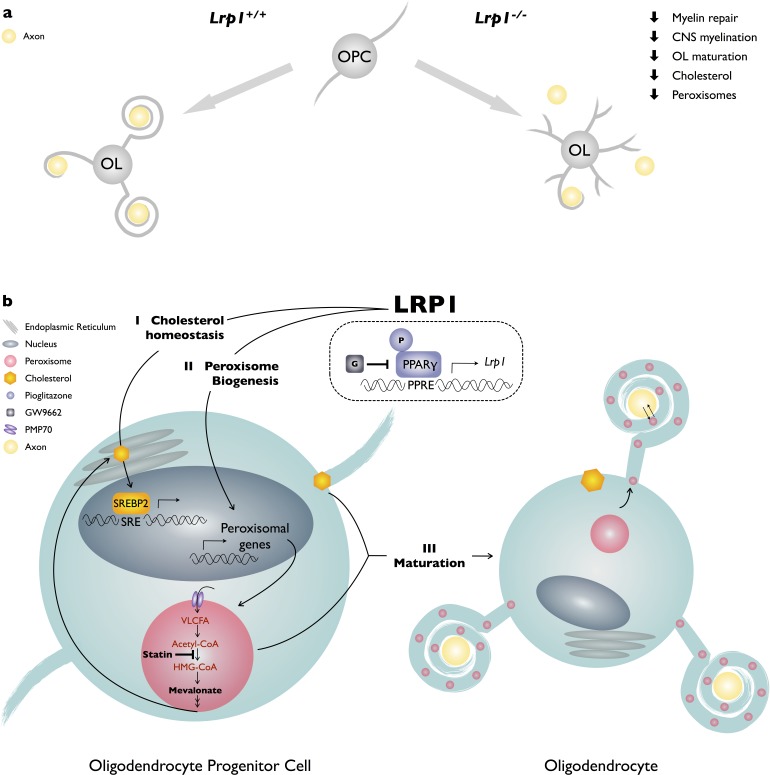
Working model of LRP1 regulated pathways in developing OLs.(a) LRP1 in the OL-lineage is necessary for proper CNS myelin development and the timely repair of a chemically induced focal white matter lesion. In OPCs, Lrp1 deficiency leads to dysregulation of cholesterol homeostasis and impaired peroxisome biogenesis. (b) LRP1 is a key regulator of multiple pathways important for OPC differentiation into mature myelin producing OLs: (I) LRP1 regulates cholesterol homeostatsis; (II) LRP1 regulates peroxisome biogenesis; and (III) the combined treatment of Lrp1 deficient primary OPCs with cholesterol and pioglitazone is sufficient to drive maturation into MBP+ myelin sheet producing OLs.